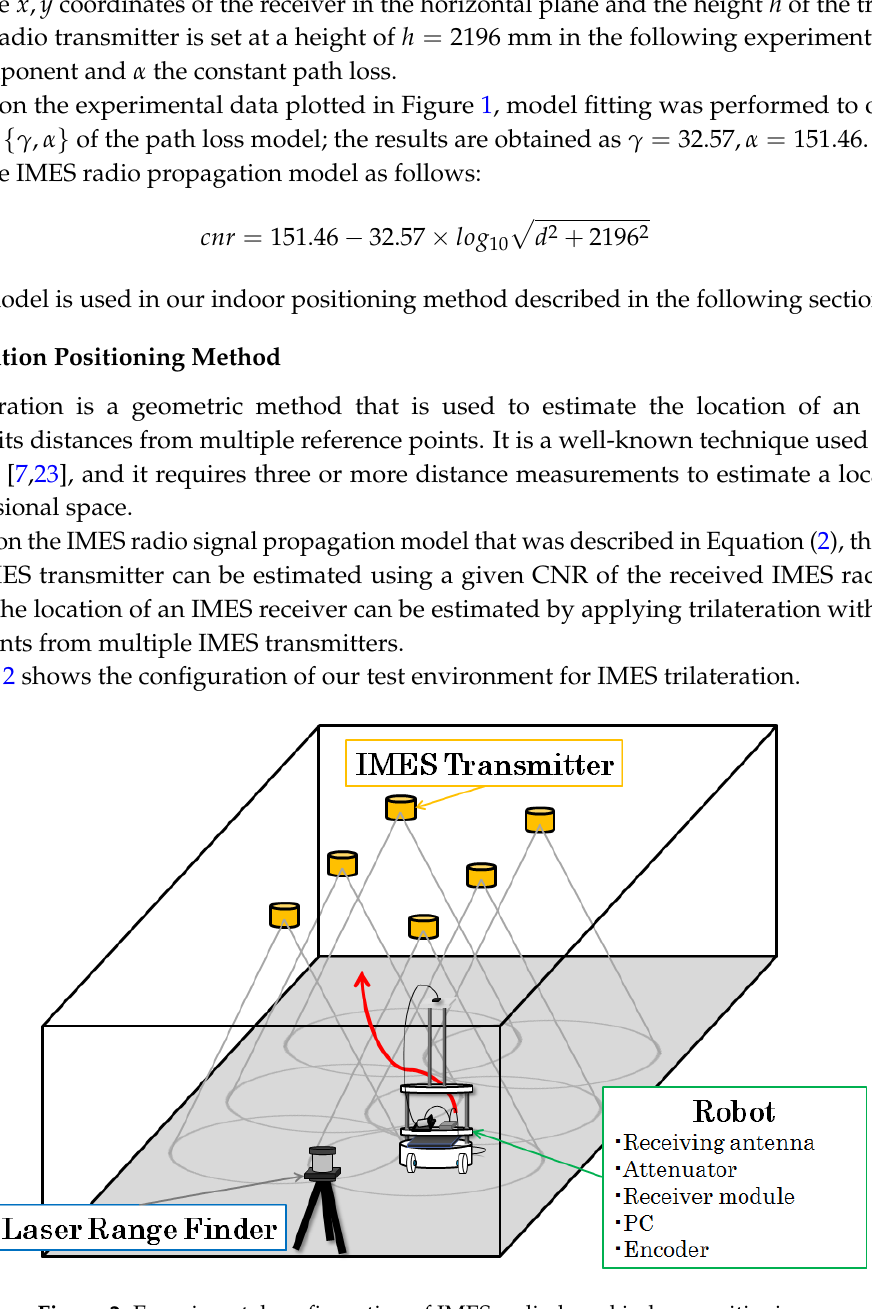
Figure 2. Experimental configuration of IMES-radio-based indoor